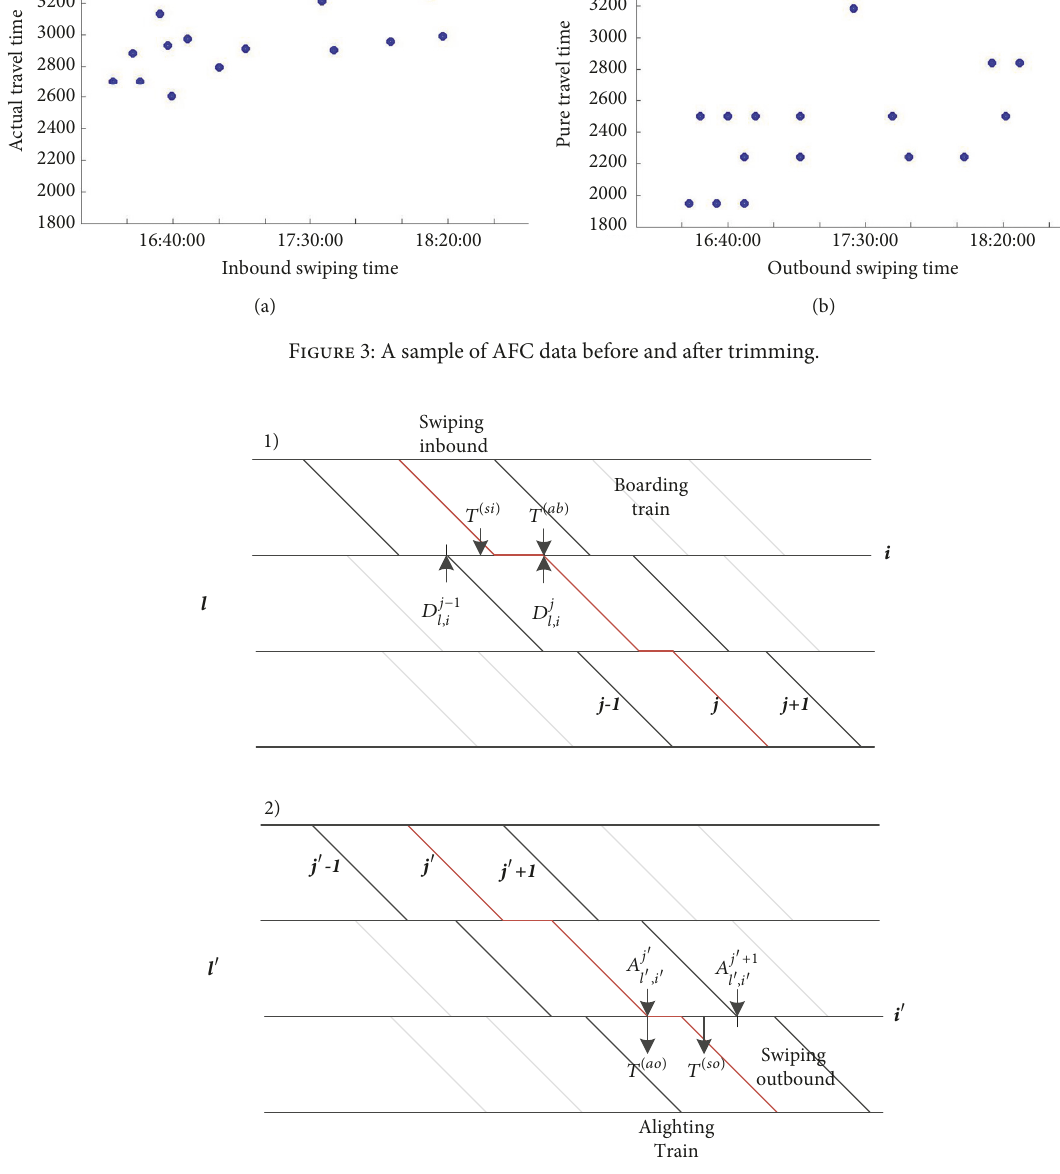
Figure 4: Determination of passengers’ actual boarding (1) and alighting (2)